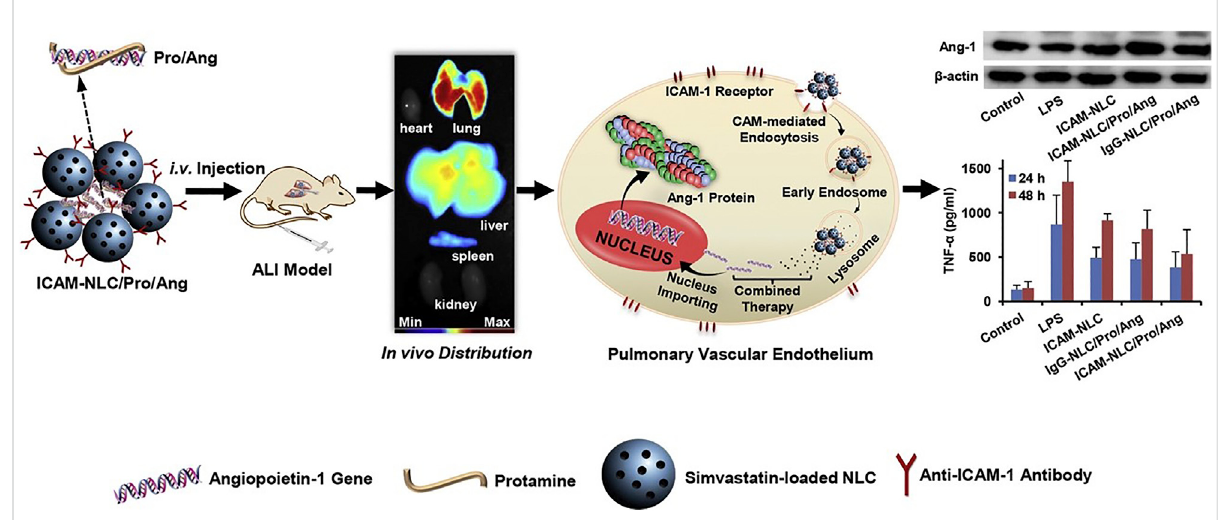
FIGURE 2 TheternaryICAM-NLC/Pro/Angnanoparticlescontainingangiopoietin-1gene,protamineandICAM-NLCwereprepared via chargeinteraction fi rstly. The ICAM-NLC/Pro/Ang exhibited ideal lung-targeted ability in lipopolysaccharide-induced ALI mice after i.v. administration, as well as the signi fi cant upregulation ofAng-1proteininlung tissue.TheICAM-NLC/Pro/Ang realizedaneffective attenuationofpulmonaryin fl ammation via co- delivery of Ang-1 gene and simvastatin to the injured lung. Collectively, the ICAM-NLC/Pro/Ang may represent a promising candidate favoring the clinical ALI therapy (Jiang et al., 2019). It was